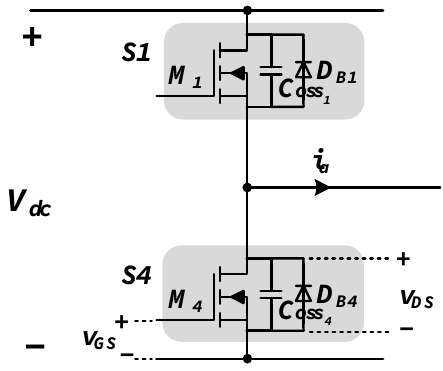
Figure 23. First leg of PV inverter and supply line-a (S:SiC power MOSFET, M:MOSFET part, C oss : output capacitance, DB: body diode, and i a : unfiltered line-a current).